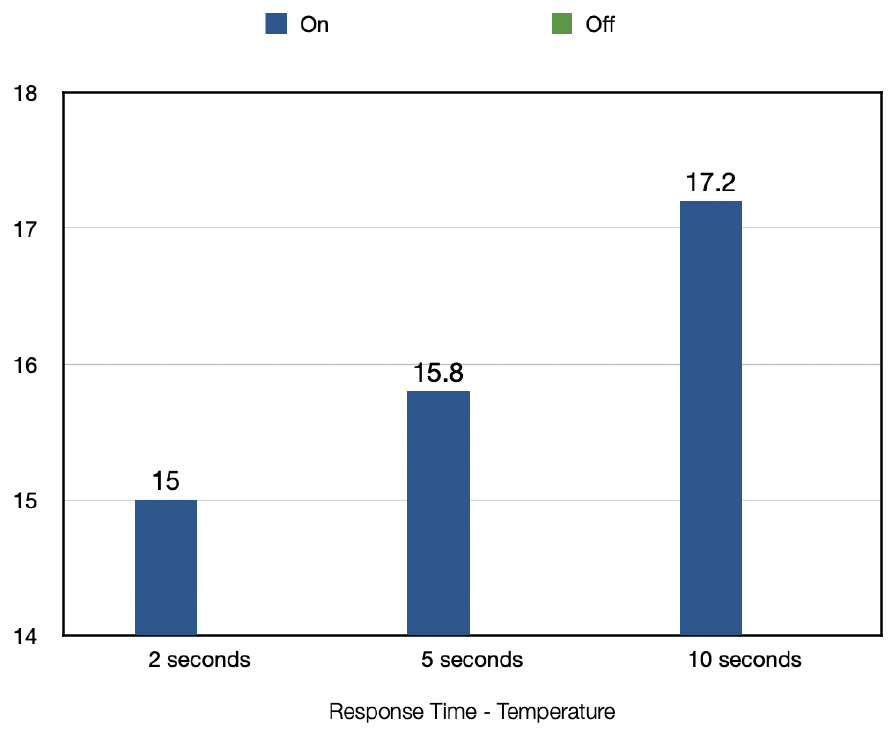
Figure 15. Visualization of Response